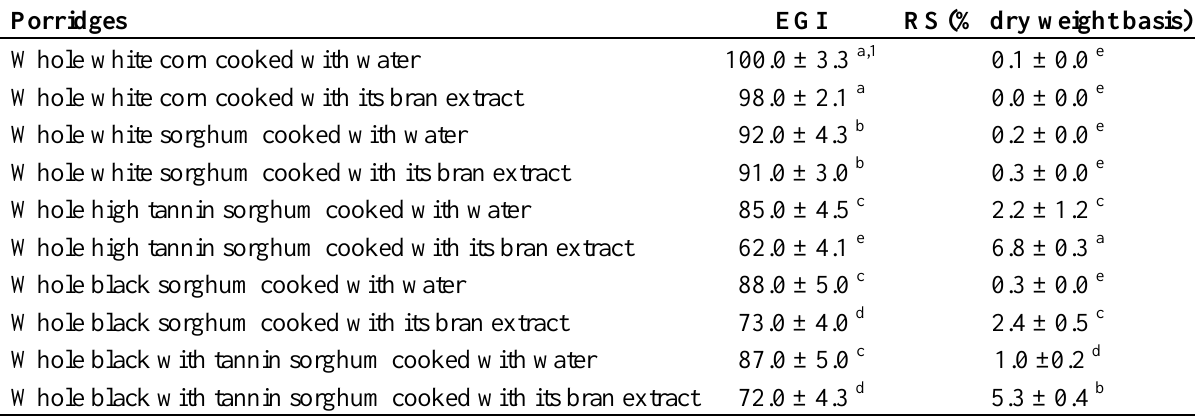
Table 5. Estimated Glycemic Index (EGI) and Resistant Starch (RS) contents of whole sorghum porridges cooked with distilled water or their corresponding bran